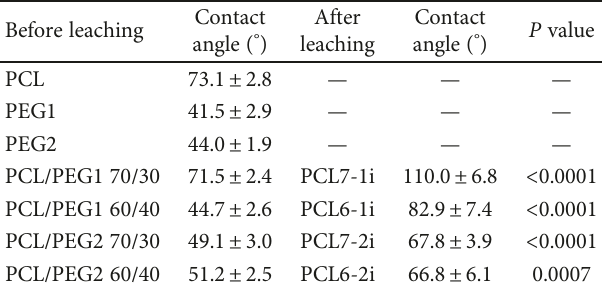
Table 4: Static contact angle values of samples before and after